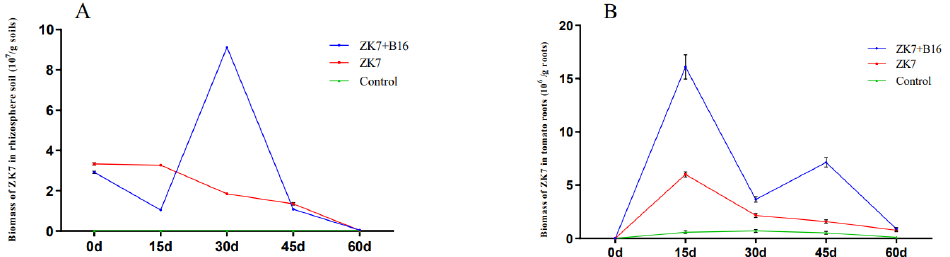
Figure 1. Changes in ZK7 colonization in root and rhizosphere soil of tomato in pot experiment. ( A ): Colonizations of P. chlamydosporia ZK7 in tomato rhizosphere soil; ( B ): colonizations of P. chlamydosporia ZK7 in tomato root. B16+ZK7: the supernatant of B. nematocida B16 was mixed with the spore suspension of P. chlamydosporia ZK7 in a ratio of 1:7 (total volume: 100 mL). Data are expressed as the average of three replicates ± SD (standard deviation).